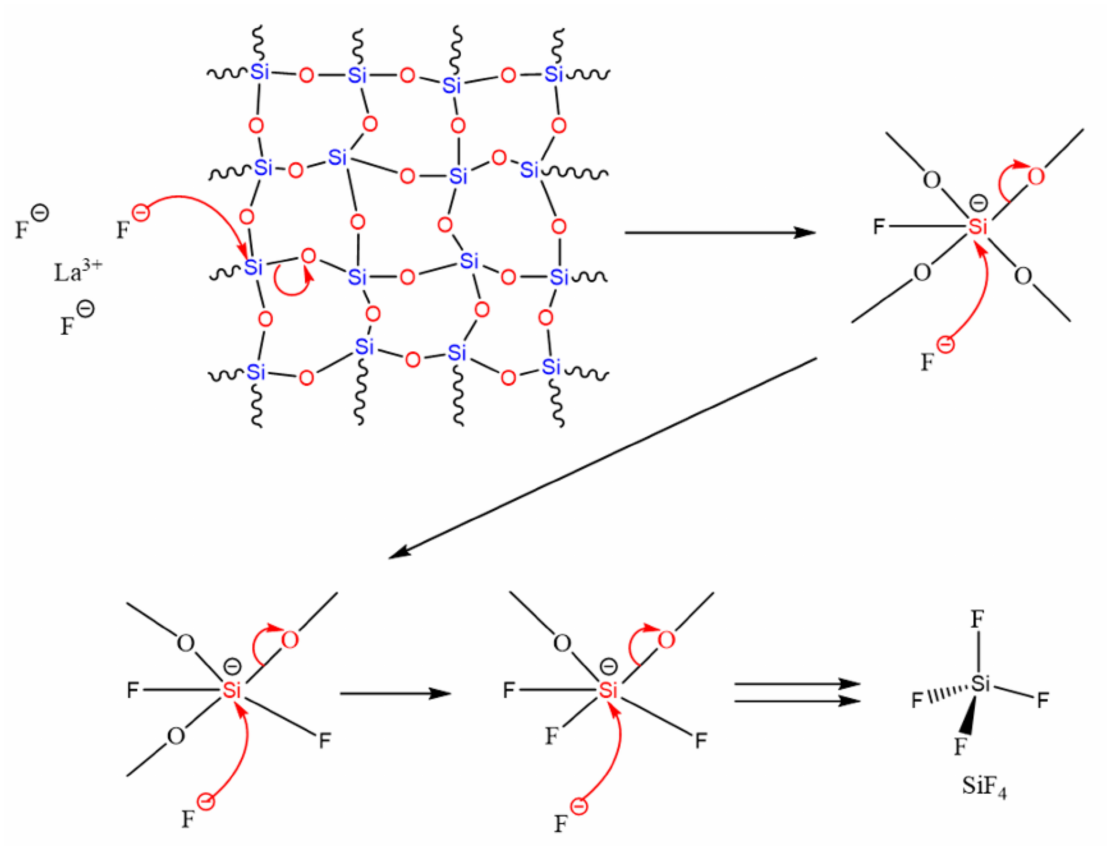
Figure 17. SiF 4 release mechanism after a reaction between at high temperature silica and fluoride ions from LaF 3 .